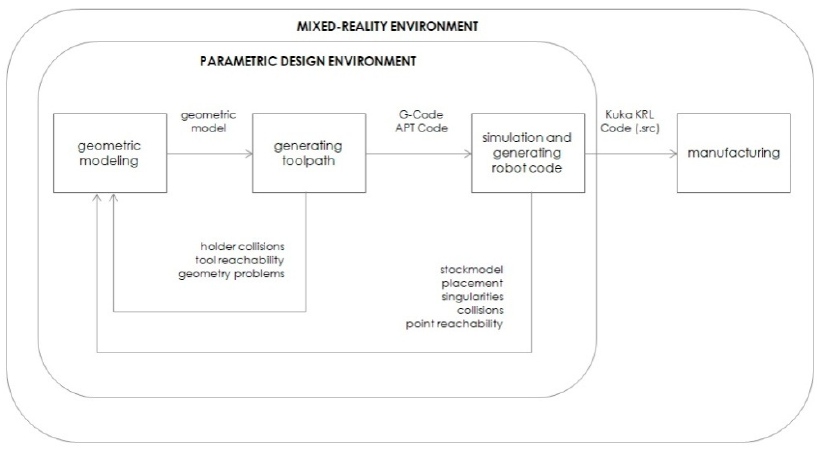
Figure 2. Parametric design and robotic fabrication within mixed-reality-environment